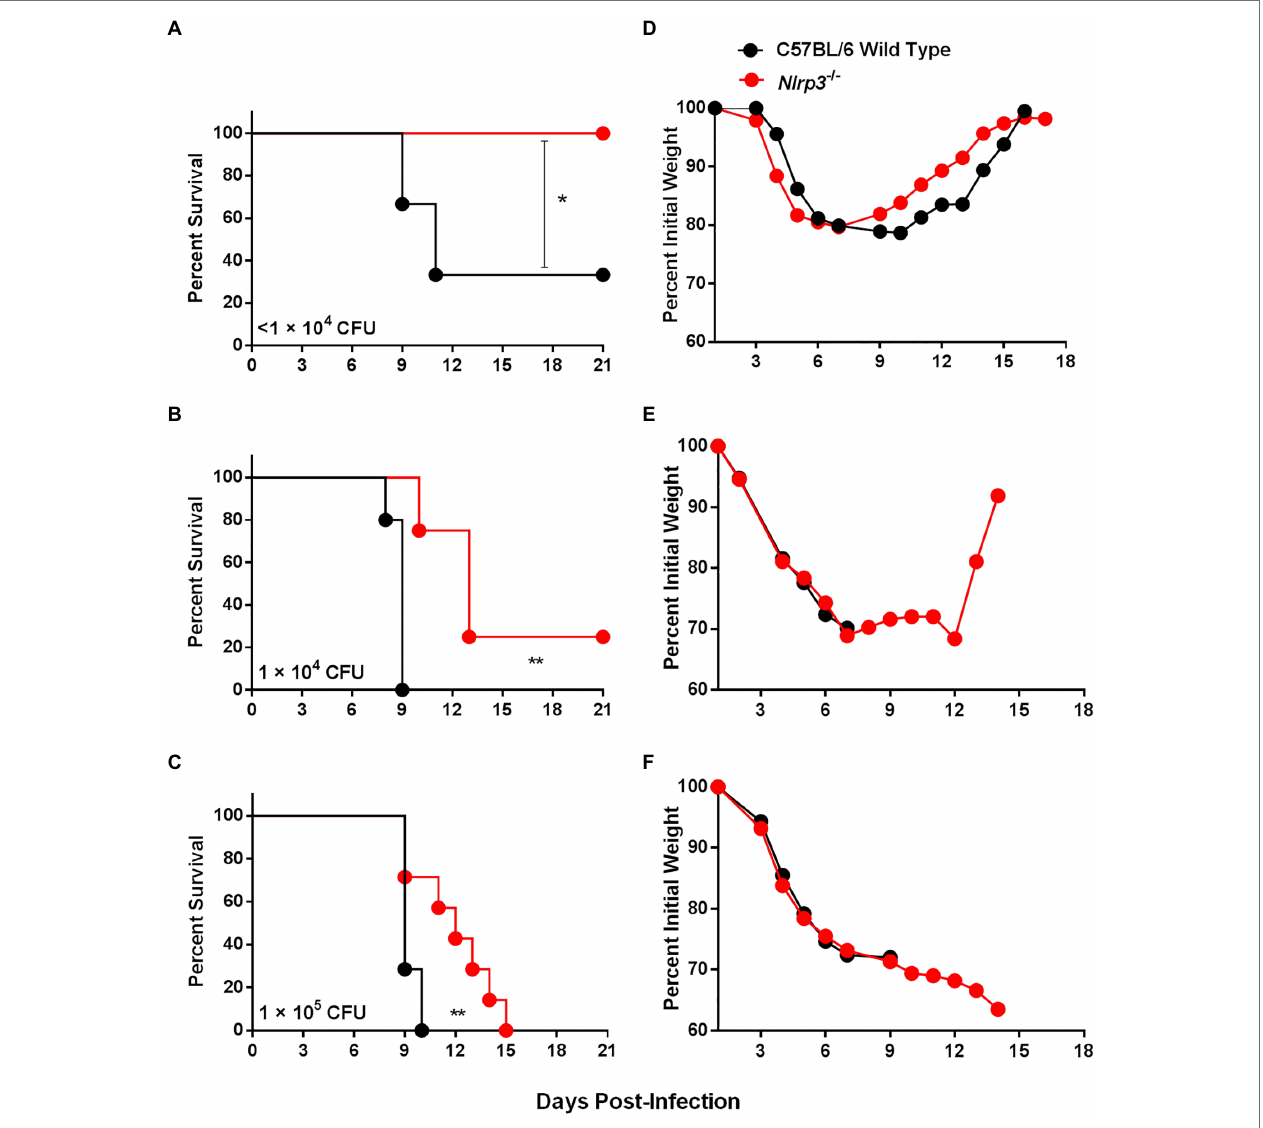
FIGURE 6 | Nlrp3 deficiency results in enhanced survival of F. tularensis LVS-infected mice. (A–C) Survival graph of C57BL/6 wild-type and Nlrp3 − / − mice ( n = 6–8 mice/group) infected intranasally with indicated doses of F. tularensis LVS. The mice were observed for mortality for 21 days. The data were analyzed by the Log- rank test and values of p were calculated. (D–F) The infected mice were weighed at the indicated times to monitor morbidity. * p < 0.05; ** p <